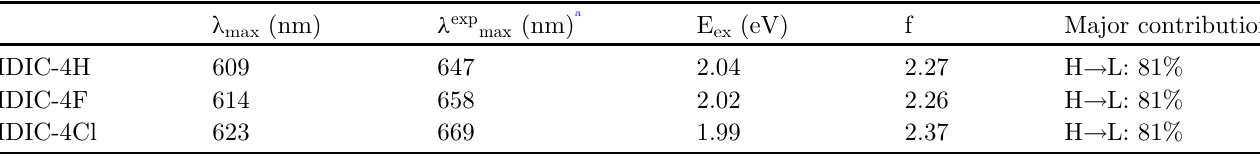
Table 2. Theoretical ( λ ) and experimental ( λ exp ) values of maximum absorption along with the excitation energy max max ), oscillator strength (f) and transition with the major contribution. (E ex